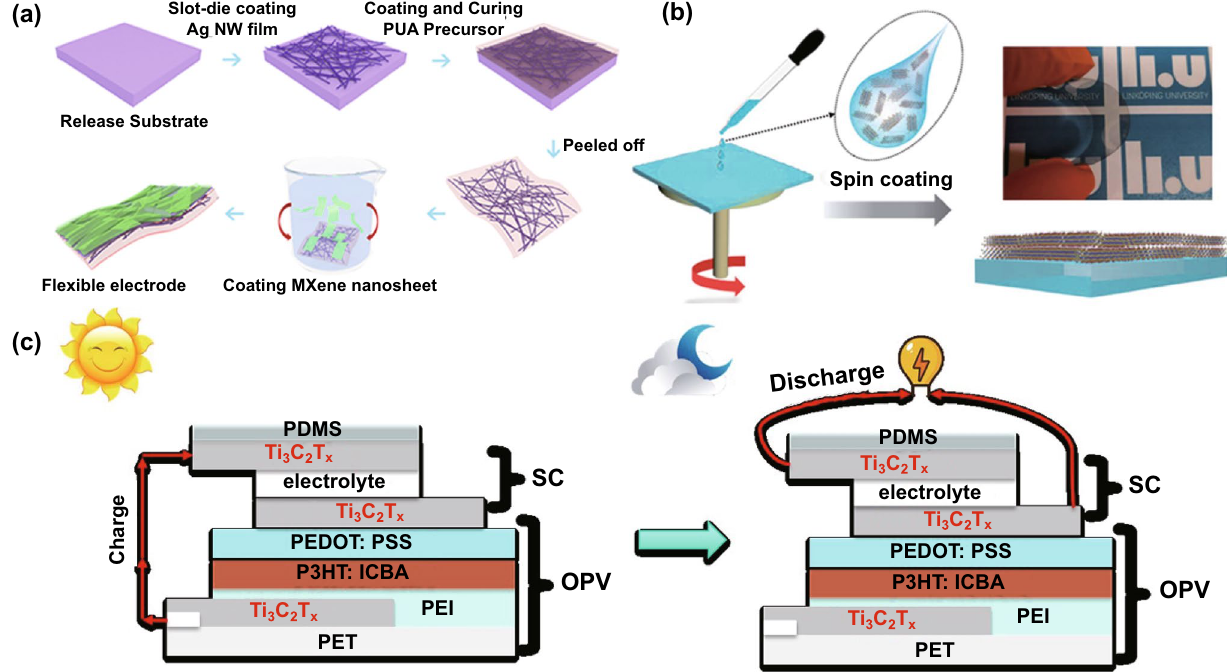
Fig. 6 a Fabrication process of the flexible transparent electrodes based on Ti 3 C 2 T x MXene nanosheets and Ag nanowire networks. Copyright © 2019 American Chemical Society. b Schematic of the preparation (left), optical photograph (upper right) and cross-sectional demonstration (lower right) of the Ti 3 C 2 T x transparent flexible electrode for the PV supercapacitors. c Working principle of the semitransparent, flexible PV supercapacitor in the charge (left) and discharge states. Copyright © 2020 The Royal Society of